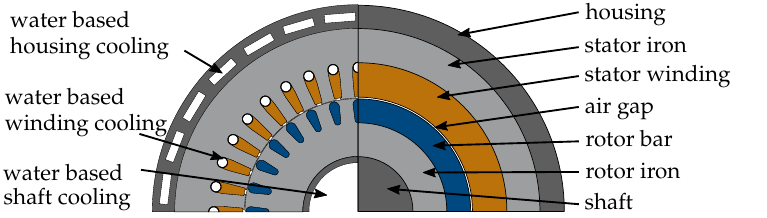
Figure 9. Real geometry ( left ) and simplified thermal shell model of the studied machine ( right ).